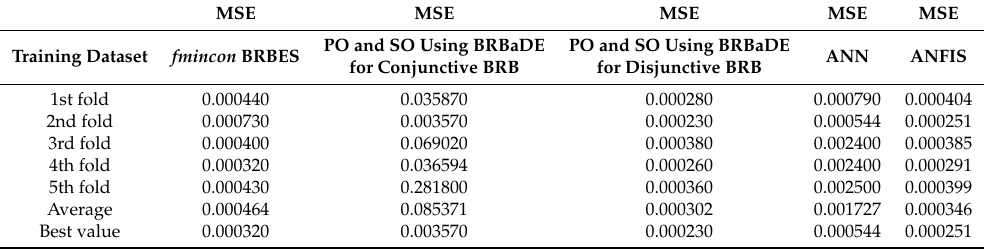
Table 5. Mean Square Error (MSE) for different kinds of BRBES using parameter optimization (PO) and structure optimization (SO) using BRBES-based adaptive Differential Evolution (BRBaDE), Adaptive Neuro Fuzzy Inference System (ANFIS), Artificial Neural Network (ANN), and the fmincon of Facebook training datasets. MSE MSE MSE MSE